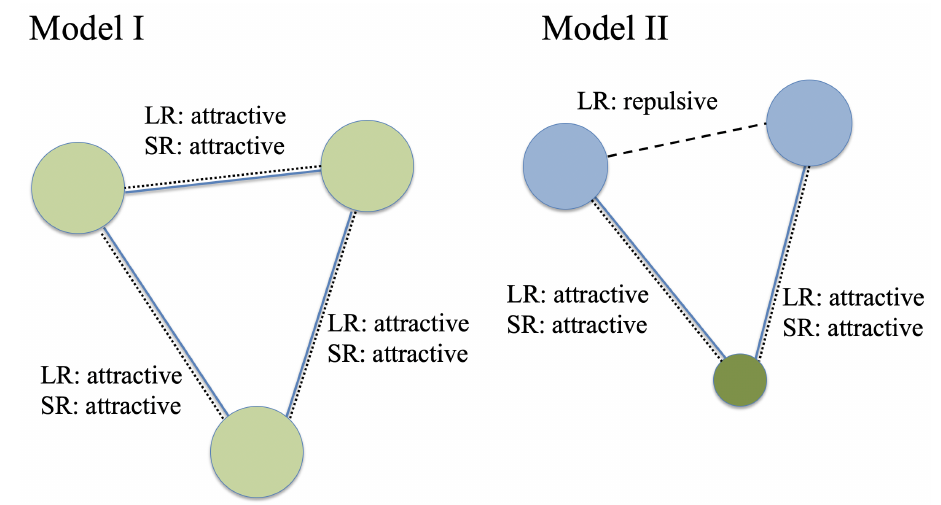
Figure 1: Schematic pictures of Model I and II employed in this paper. Solid lines represent the short-range attractive potentials, and dotted and dashed lines represent the long-range attractive and repulsive potentials,